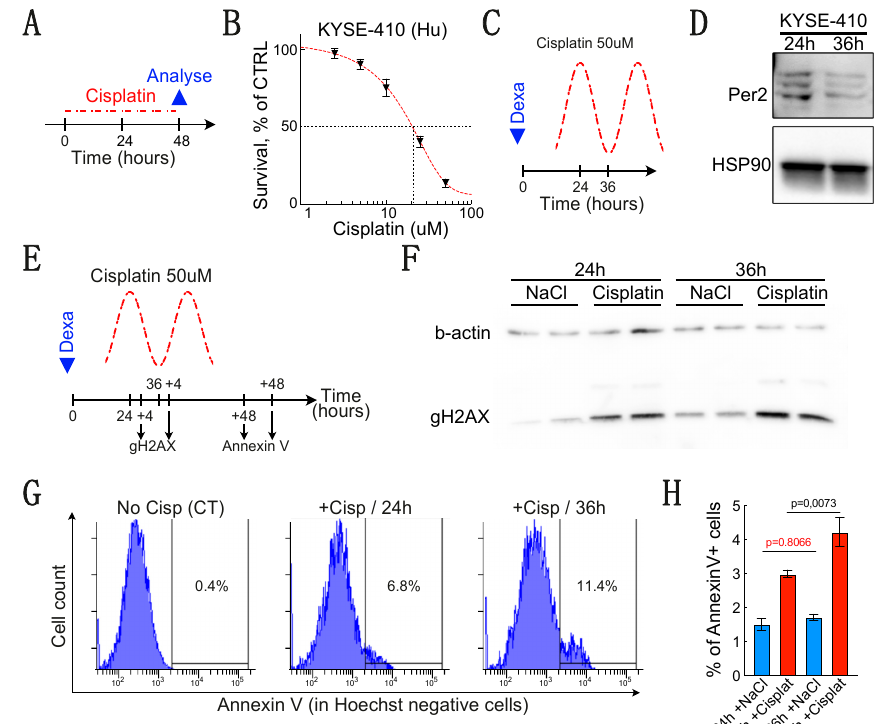
Figure 4. A low PER2 expression is associated to higher sensitivity to cisplatin-induced apoptosis. ( A ) Experimental design. ( B ) KYSE-410 survival measured using MTS assay 48 h after cisplatin treatment. The red sigmoid curve is a guide for the eye. Data are represented as mean +/ − SEM ( n = 5). ( C ) Experimental design to treat KYSE-410 when PER2 expression is high or low (24 or 36 h after synchronization respectively). ( D ) Western blot showing the expression of PER2 24 or 36 h after synchronization. ( E ) Schematic representation of the cisplatin treatment timeline and the time-points selected to collect the samples for DNA damage ( γ H2AX) evaluation and apoptosis (annexin V) measurement. ( F ) Western blot showing the expression of γ H2AX after a 4-h cisplatin treatment either 24 or 36 h post-synchronization. Cells were either treated with vehicle alone (NaCl) or with 50 µM cisplatin. ( G ) Representative histogram showing the proportion of Hoechst-/Annexin V KYSE-410 cells measured by flow cytometry 48 h after the end of the cisplatin treatment. Cells were either not treated (NaCl = vehicle) or treated for 4 h with 50 µM cisplatin 24 or 36 h after synchronization. ( H ) Histogram summarizing the proportion of Hoechst-/Annexin V KYSE-410 cells measured 48h after the end of the cisplatin treatment. Data are represented as mean +/ − SEM ( n = 8). p -values were calculated using a two-way ANOVA followed by Sidak’s post hoc test. Fixed effect: Time/ p = 0.0110; Cisplatin/ p < 0.0001; Time x Cisplatin/ p = 0.0527.